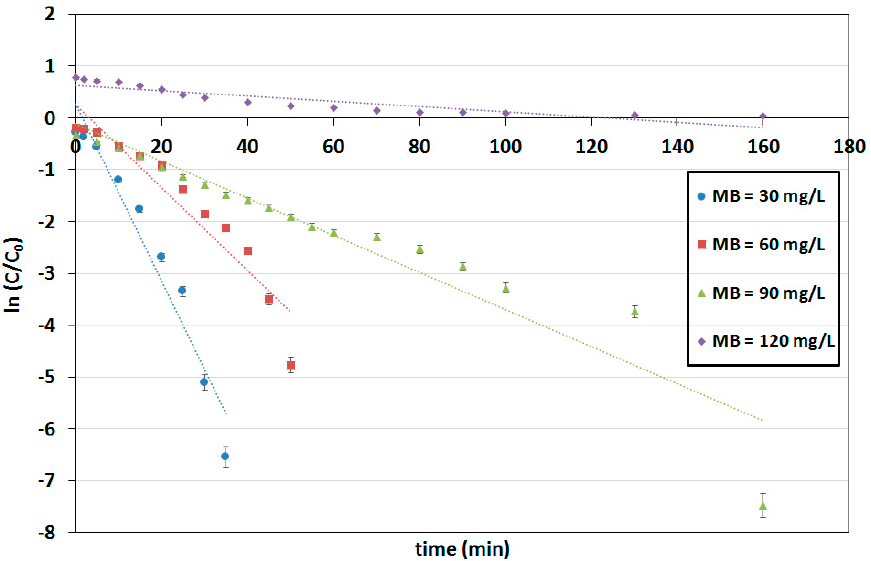
Figure 5. Pseudo-first-order model for the MB concentration effect on photocatalytic activity, fitted to their linear plots (pH neutral; DTiO 2 = 1 g/L; temperature = 20 ± 2 °C).